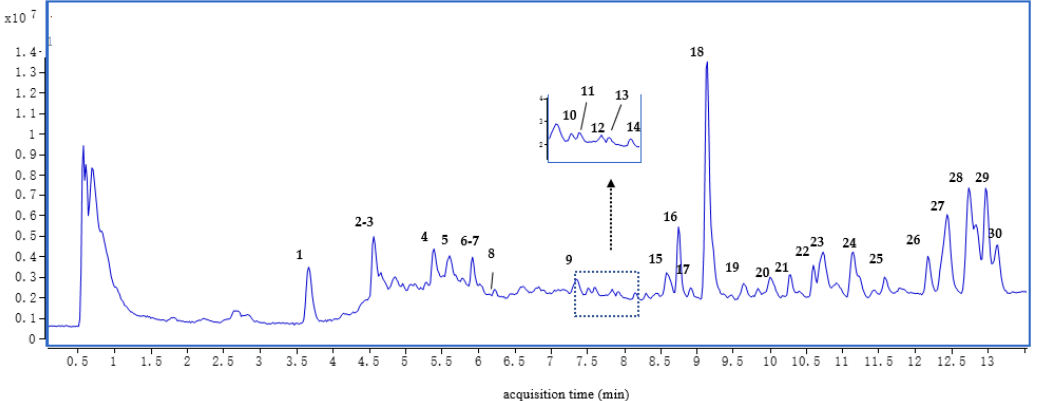
Figure 2. Total ion of chromatography (TIC) in a mixed solution of all RAS samples. The MS of compound 1 showed a protonated molecular ion [M + H] + at m / z 205.0972 and [M +